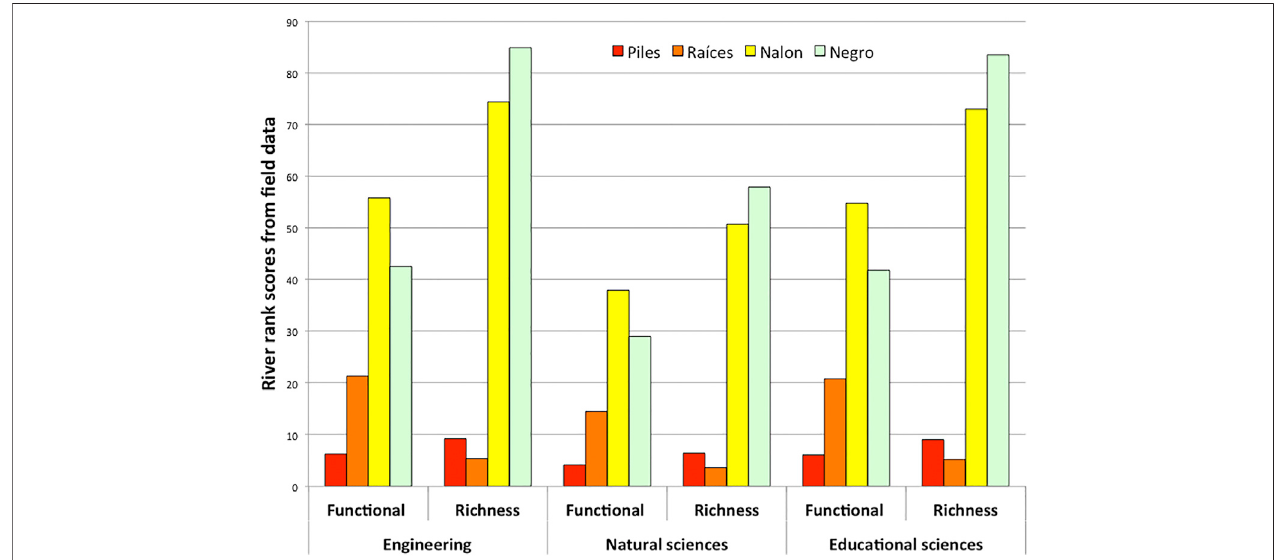
FIGURE 4 | Relative value of the four rivers analyzed in the model, estimated from the features considered. Products of multiplication of the ranks allocated to river features, weighted by the preference coef fi cients calculated from students ’ willingness to pay. Two values are given for each river, using functional diversity “ Functional ” (in fl uencedbynon-nativespecies)orspeciesrichness “ Richness ” asestimatorsof fi shdiversity.Theotherfeaturesarethesameinthetwoestimatedvaluesofeachriver: connectivity, environmental quality, fi sh abundance, and number of native fi sh